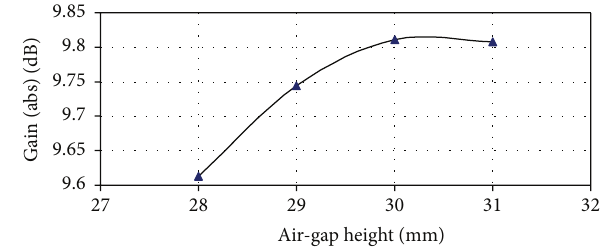
Figure 15: Gain versus air-gap height at 5.8 GHz.